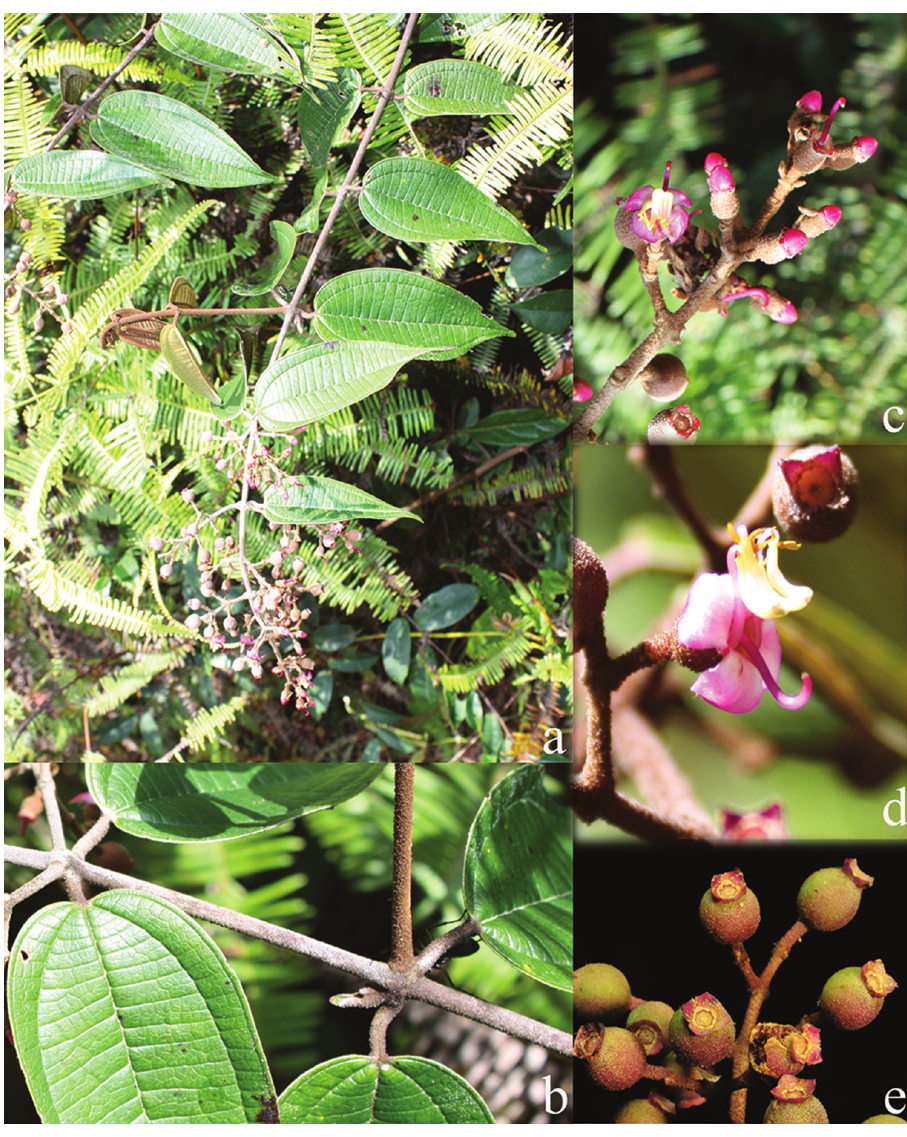
Figure 9. Dissochaeta celebica var. celebica a habit b branchlet c hypanthium d flowers e fruits. Photo- graphs by Supriatna; voucher: Widjaja et al. 9846a (BO).